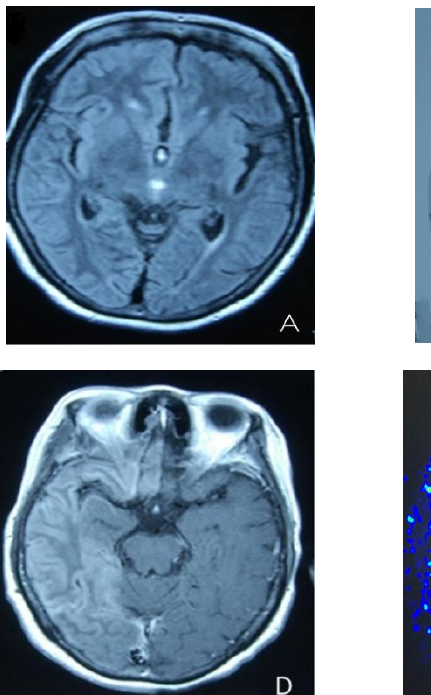
Figure 2. ( A , B ) Previously demonstrated the swelling of cerebral cortex has resolved; ( C ) hyperfu- sion in the right hemisphere has returned to normal. ( D ) Bilateral MCA and PCA were relatively symmetrical. Figure 3. Time course of the disease. Diagram illustrating time course of disease in our patient. 3. Discussion Over the past few decades, neurophysiological and neuroimaging studies have pro- vided consistent evidence supporting CSD as a neurophysiological process in migraines.